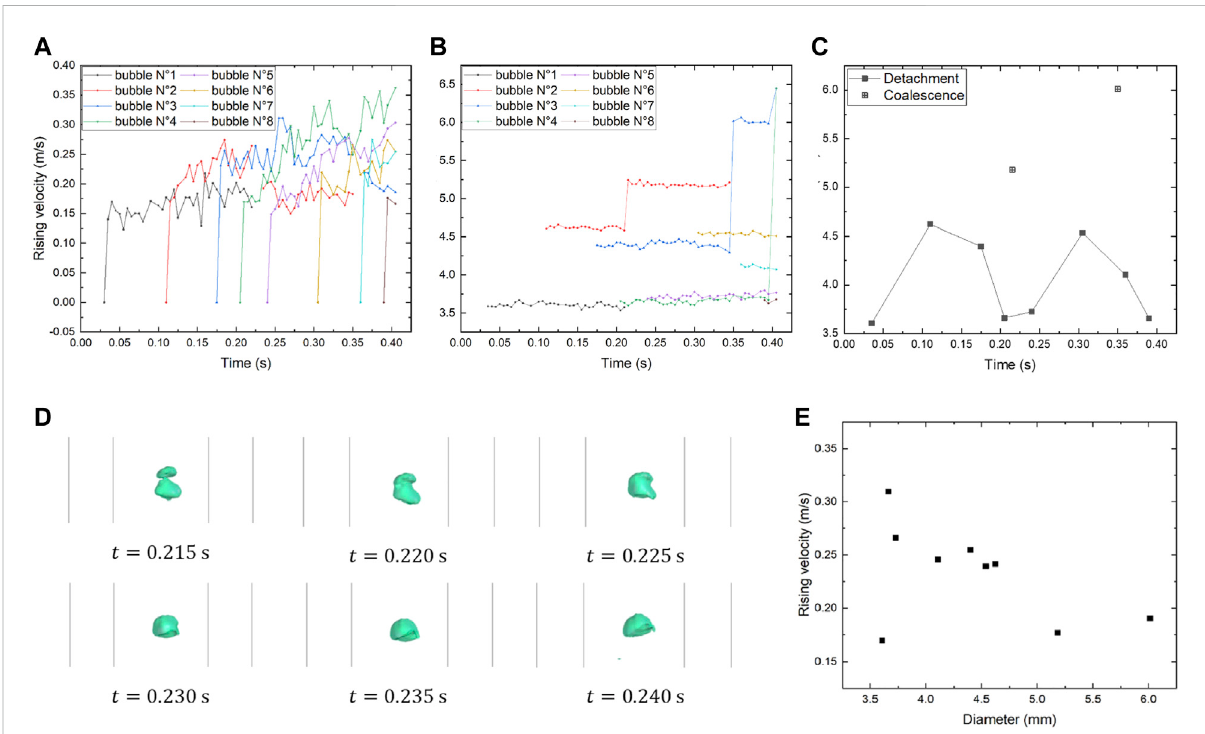
FIGURE 7 Simulation results of bubbles released by gas injection in molten LBE, v g (cid:1) 1 m / s . (A) Rising velocity. (B) Equivalent diameters. (C) Detachment and coalescence. (D) Coalescence of bubbles No. 1 and 2. (E) Terminal rising